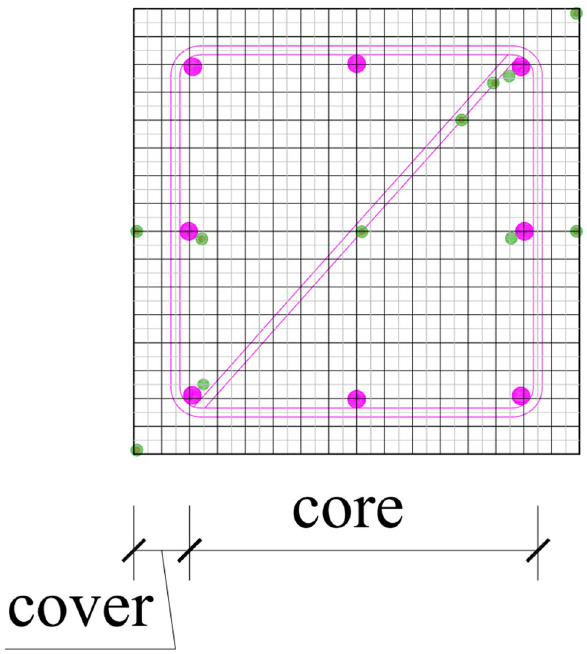
Figure 8. 2D concrete model used for the thermal analysis (the transverse and longitudinal reinforcement as well as the location of the thermocouples are included for guidance).